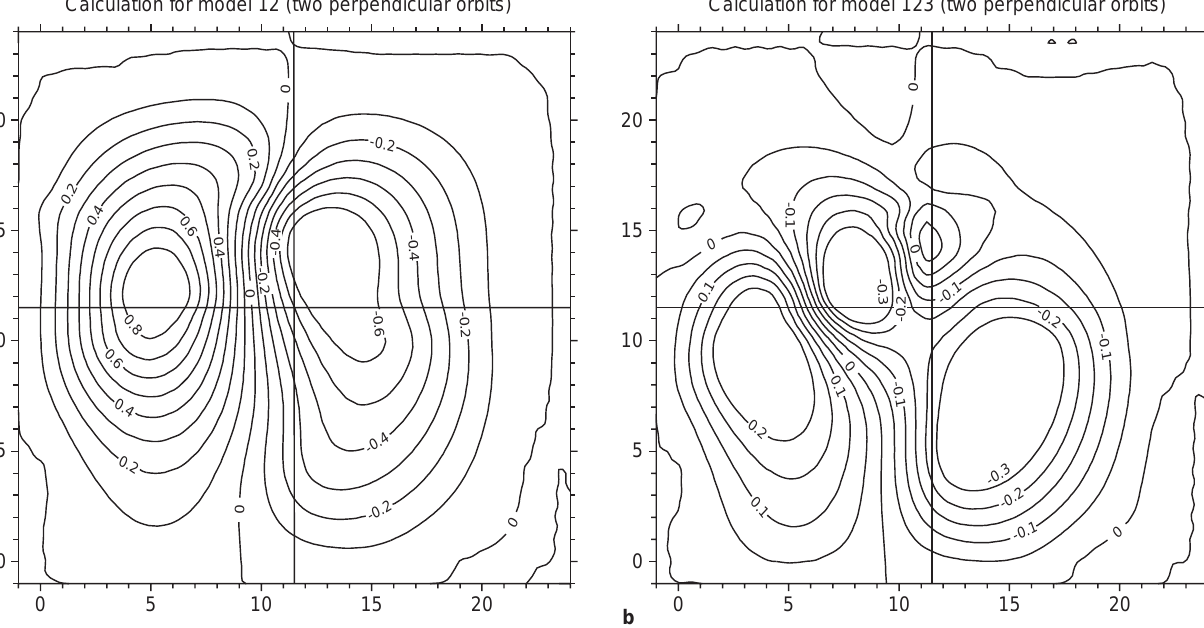
Calculation for model 123 (two perpendicular orbits)